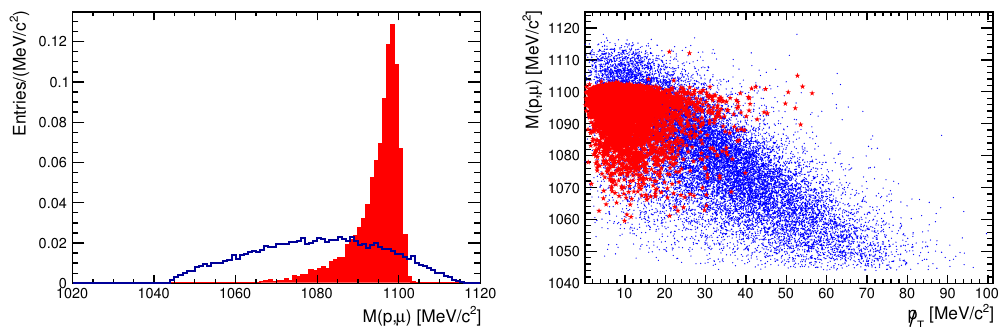
Figure 9 . The left plot shows the reconstructed invariant mass for (cid:3) events are given by a solid blue line, while the (cid:3) right (cid:12)gure shows a scatter plot of the reconstructed mass vs. missing momentum in the plane transverse to the (cid:3) (cid:13)ight direction for signal (blue squares) and (cid:3) Final state radiation in the (cid:3) decay vertex is not included in the